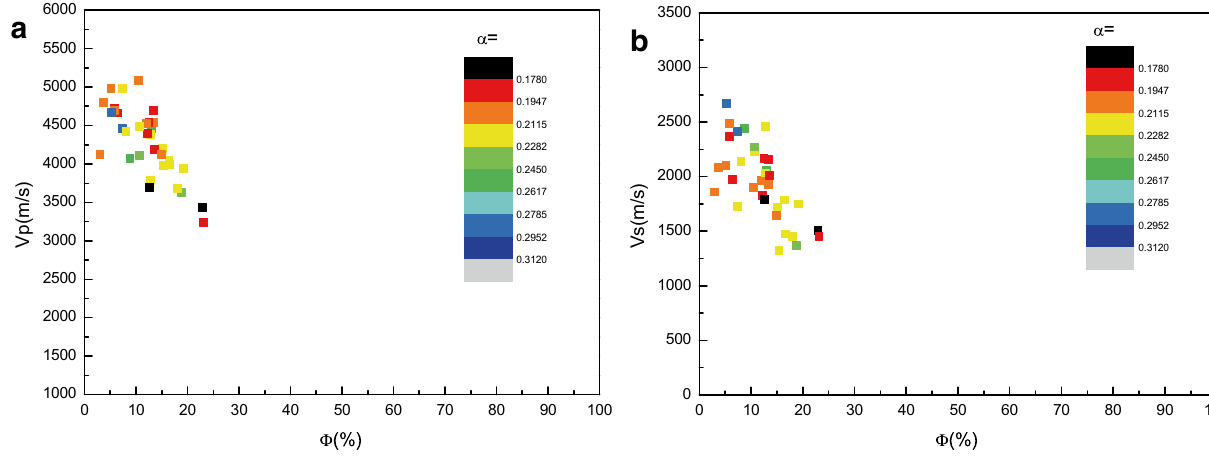
Fig. 3 a Experimental relationship between V